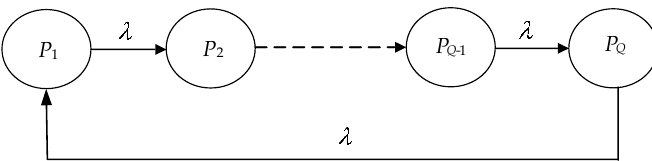
Figure 1. Non-aggregate Markov model of photovoltaic output.